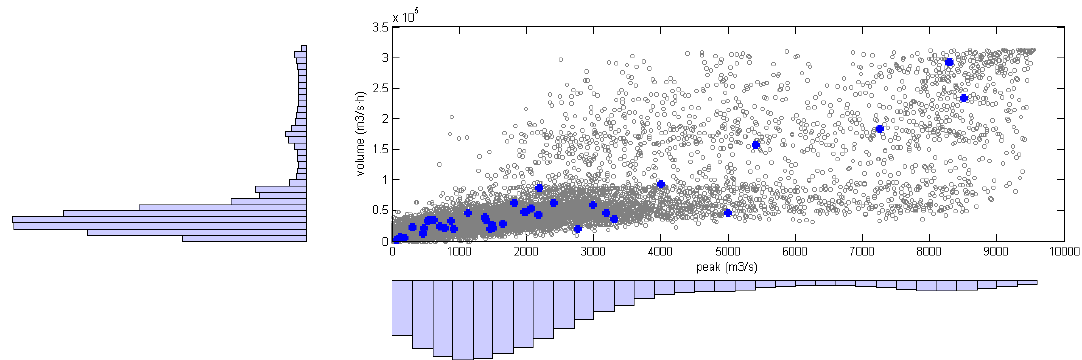
Figure 8. Scatterhist of 10,000 synthetic peak–volume samples (hollow points) and observed samples (solid points).